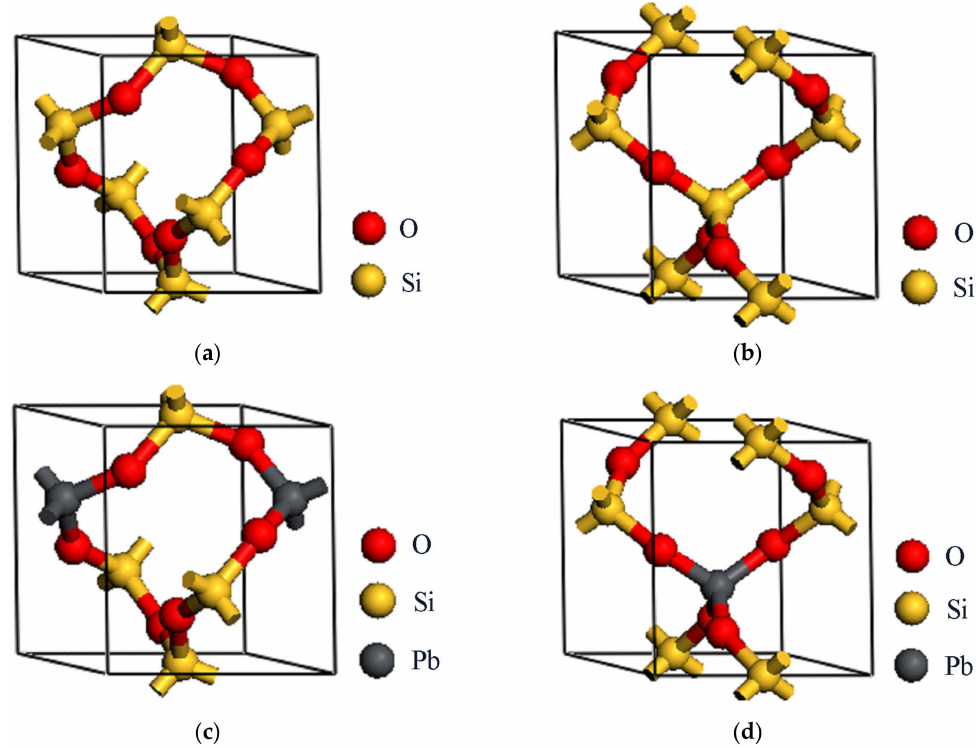
Figure 1. The structures of Raman crystals ( a ) α -SiO 2, ( b ) β -SiO 2, ( c ) Pb 4 + -doped α -SiO 2, ( d ) Pb 4 + -doped β -SiO 2